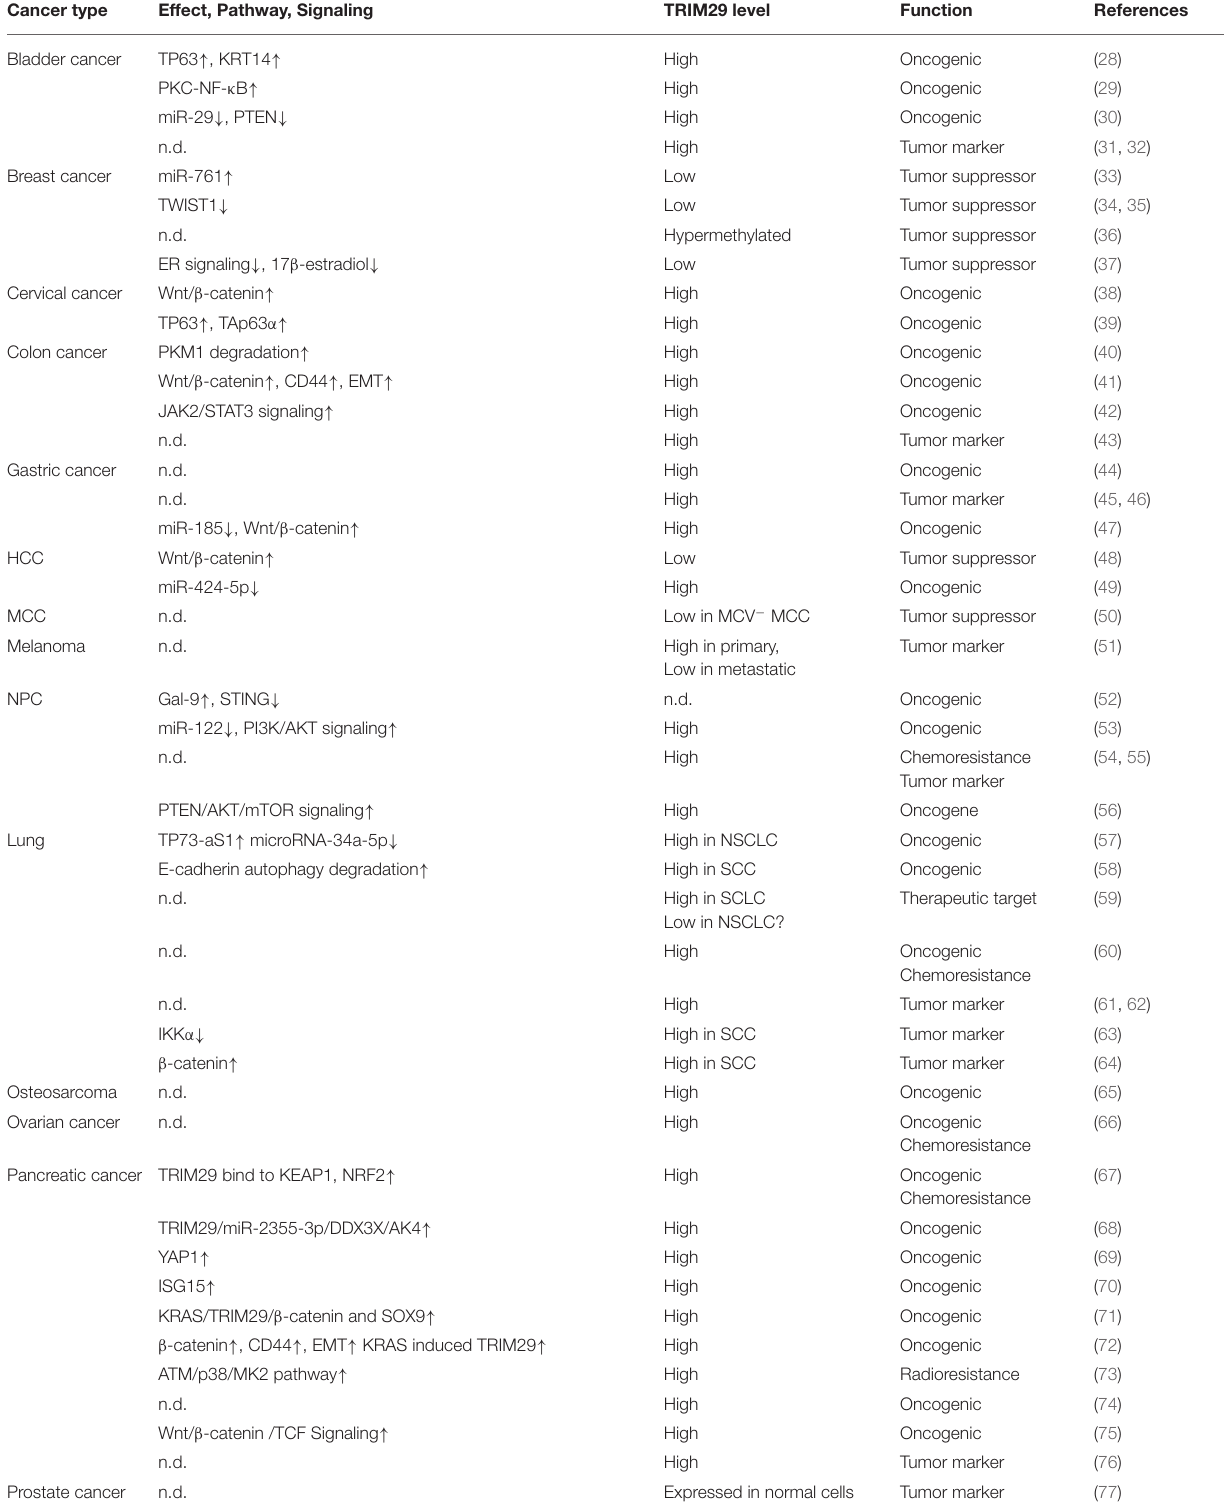
TABLE 1 | Effect and expression of TRIM29 proteins in different cancers. Cancer